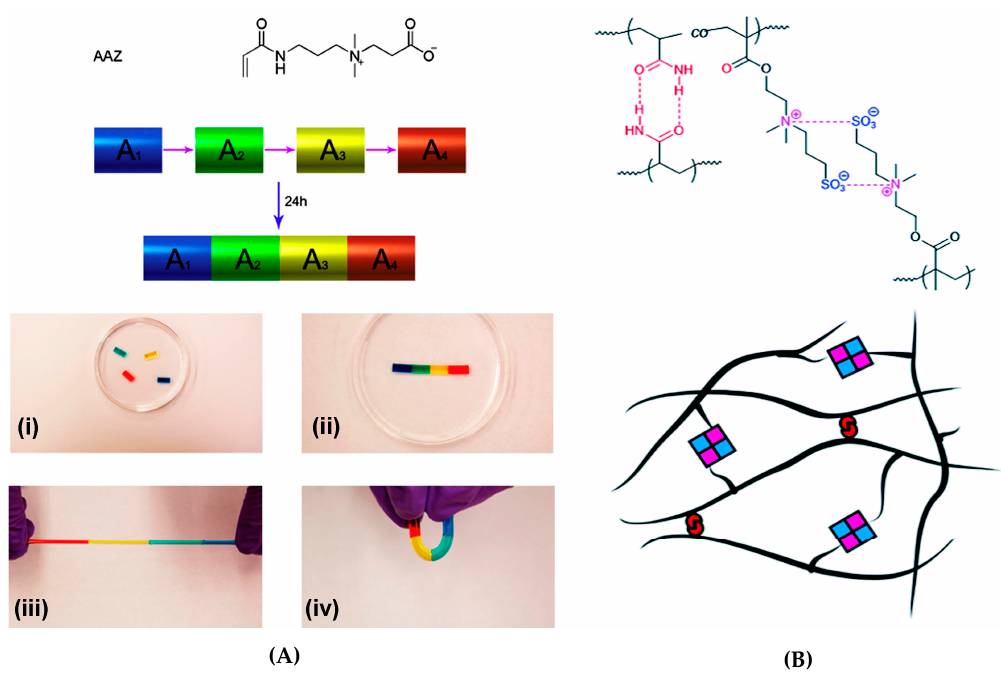
Figure 12. ( A ) Carboxybetaine acrylate (AAZ) monomer and the fusion of its homopolymer hydrogels from separate blocks (A 1 –A 4 , ( i )) into a uniform gel ( ii ) that can be stretched ( iii ) and bent ( iv ) without breaking. A 1 ( blue ), A 2 ( green ), A 3 ( yellow ) and A 4 ( red ) have the same composition [144]; ( B ) Reversible hydrogen bonding and electrostatic interactions of a P(AAm- co -DMAPS) copolymer, resulting in crosslinked hydrogel formation. Reprinted with permissions from [144,145]. Copyright 2016 Elsevier and Royal Society of Chemistry.